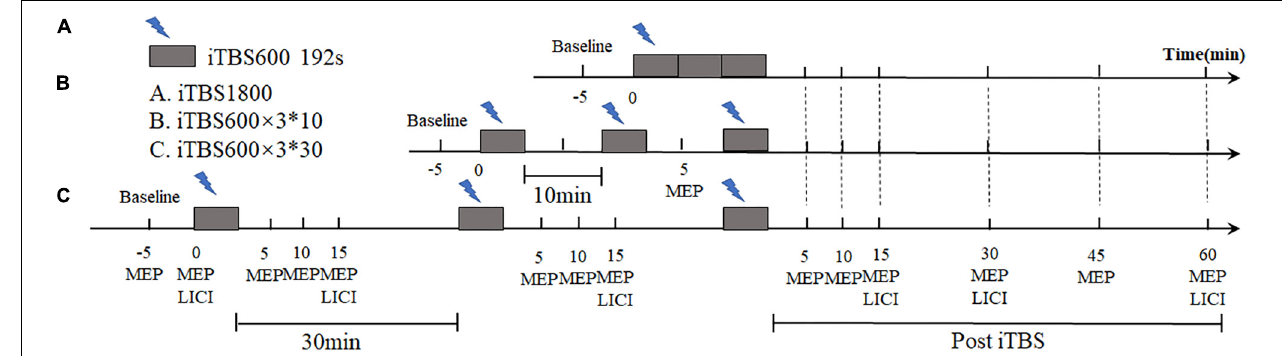
FIGURE 1 | Experimental design. Using a within-subjects cross-over design, each subject took part in three sessions in different day. MEPs and LICI were assessed before and post iTBS intervention. The time required for (A) iTBS1800 to received iTBS protocol was 9 min and 52 s. (B) iTBS600 × 3 ∗ 10 was required to receive three blocks of iTBS stimuli, each of which was 10 min apart. the total stimulus time was 29 min and 36 s. (C) iTBS600 × 3 ∗ 30 received three blocks of iTBS stimuli at a 30-min interval, the total stimulus time was 69 min and 36 s.